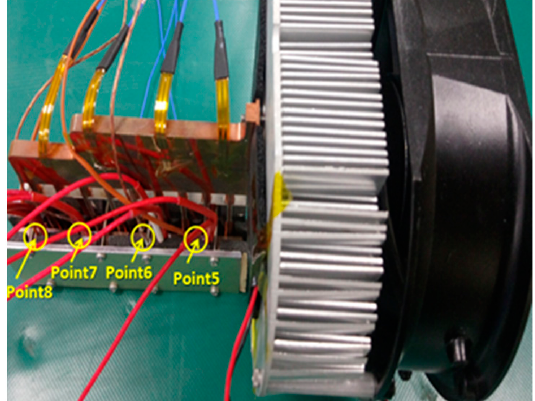
Figure 16. Measurement configuration diagram.